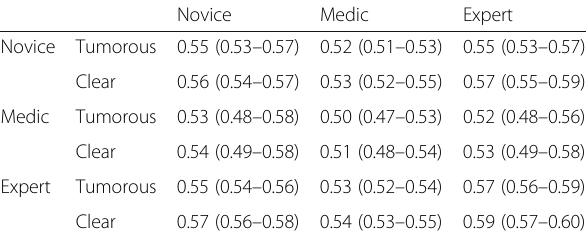
Table 3 Means (95% CI) for each between-group comparison and actual diagnosis for ScanMatch similarity scores